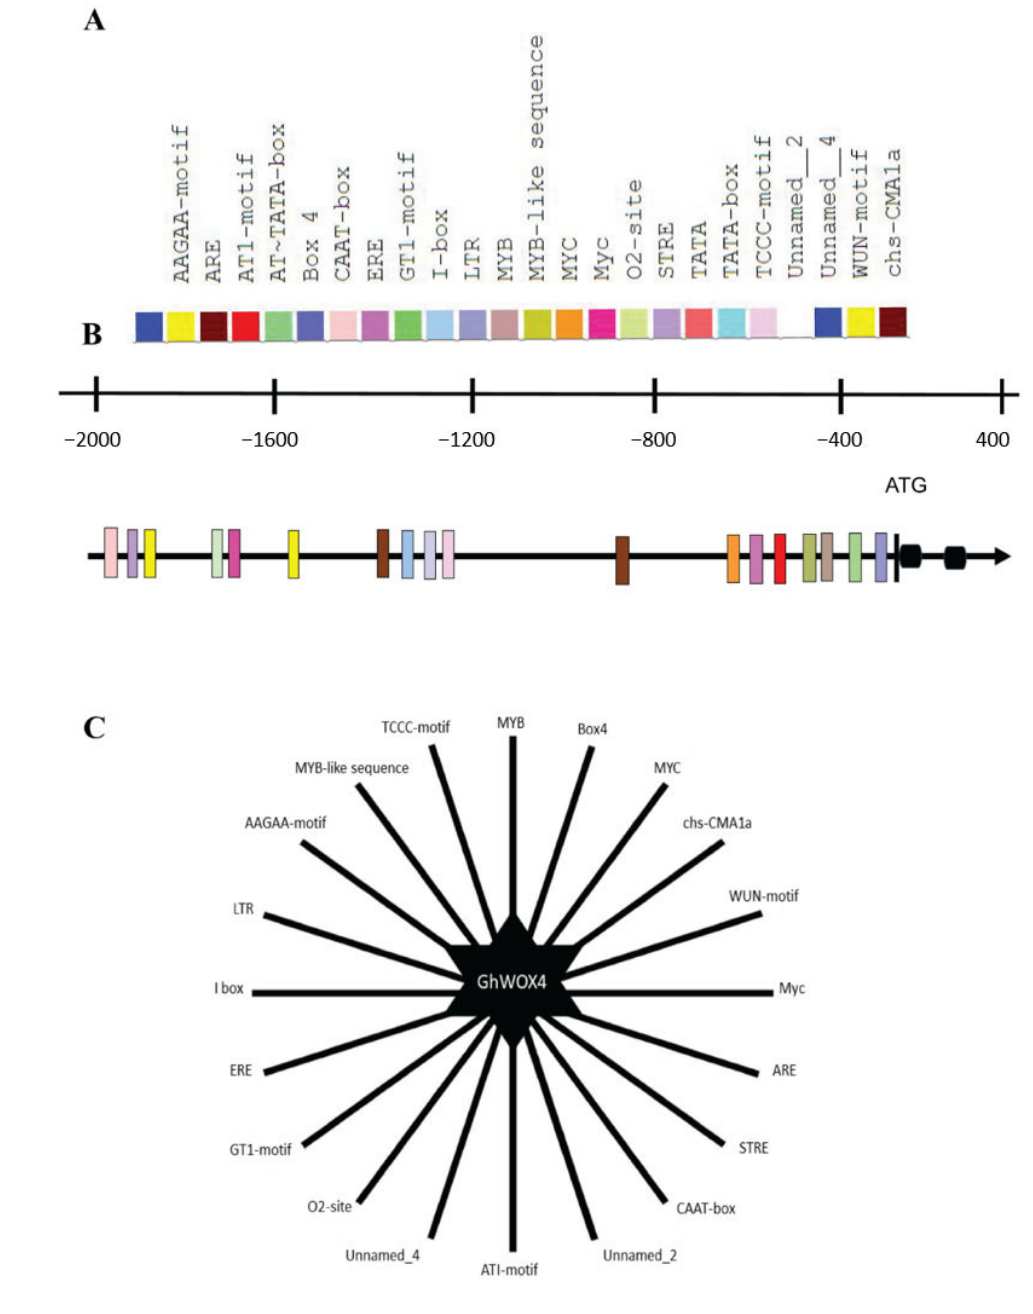
Figure 9. In silico promotor analysis. ( A ) Plantcare-database derived cis-regulatory elements (CREs). ( B ) Position of CREs, 2000 bp upstream to ATG (start codon) with respect to scale; black-filled terminator represents “ATG”, black rectangles represent exons, black horizontal lines represent introns. ( C ) Illustration representing total CREs reported in the promotor region of